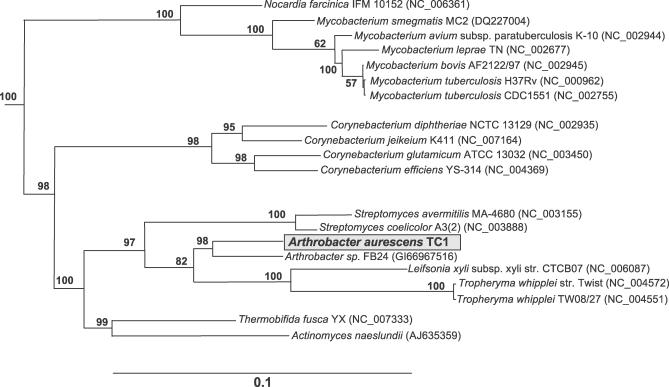
Maximum Likelihood Bootstrap Majority-Rule Consensus Tree for 16S rRNA Gene Sequences from 19 Strains Phylogenetically Related to A. aurescens TC1Numbers adjacent to branch points are bootstrap percentages (n = 100 replicates). The bar represents 10% sequence divergence.